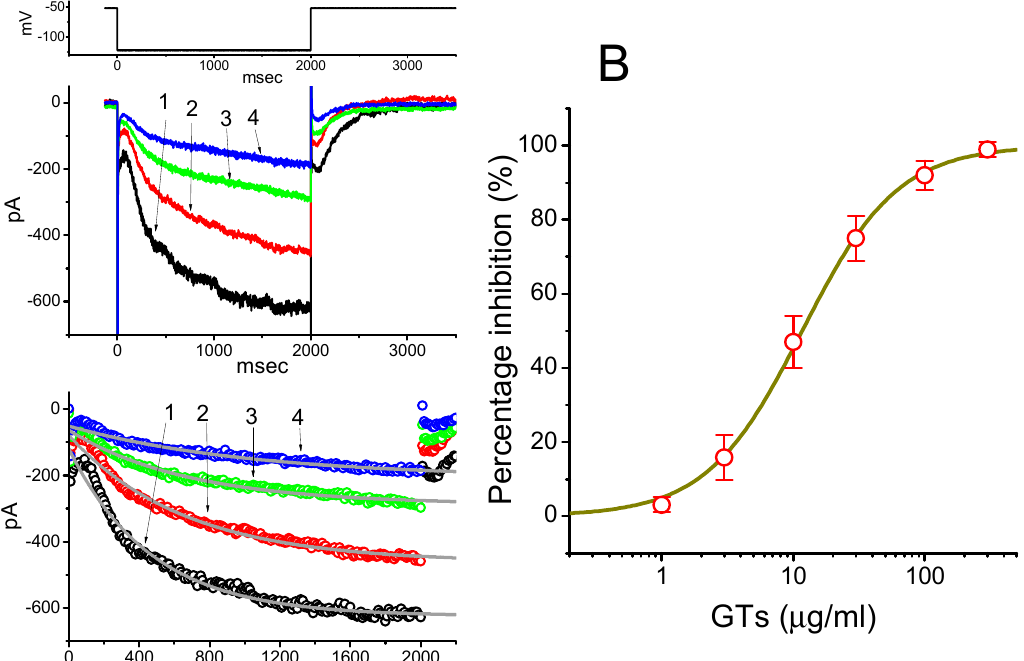
Figure 1. E ff ect of Ganoderma triterpenoids (GTs) on hyperpolarization-activated cation current in pituitary tumor (GH 3 ) cells. In these whole-cell current recordings, cells were bathed in Ca 2 + -free, Tyrode’s solution, and we backfilled the recording electrode by using a K + -containing solution. The hyperpolarizing step from − 52 to − 122 mV was applied to the examined cells. ( A ) Superimposed I h traces obtained in the absence (1) and presence of 10 µ g / mL GTs (2), 30 µ g / mL GTs (3) and 100 µ g / mL GTs (4). The uppermost part is the voltage profile used. The lower part depicts the trajectory of each I h trace shown in the upper panel (in the absence (1) and presence of 10 µ g / mL GTs (2), 30 µ g / mL GTs (3) and 100 µ g / mL GTs (4)) was fitted by single exponential with the activation time constant ( τ act ) of 467, 657, 680 and 1037 msec, respectively. For better illustration, the data points (circles symbols) were reduced by a factor of 10. ( B ) Dose-dependent relation of GTs e ff ect on I h amplitude (mean ± SEM; n = 7–9 for each point). The I h amplitudes were taken at the end of 2-sec hyperpolarizing step in the presence of di ff erent GTs doses. The continuous line was fitted with the goodness of fit by a modified Hill function described under Materials and Methods. The IC 50 value required for GTs-induced suppression of I h was computed to be 11.7 µg/mL.